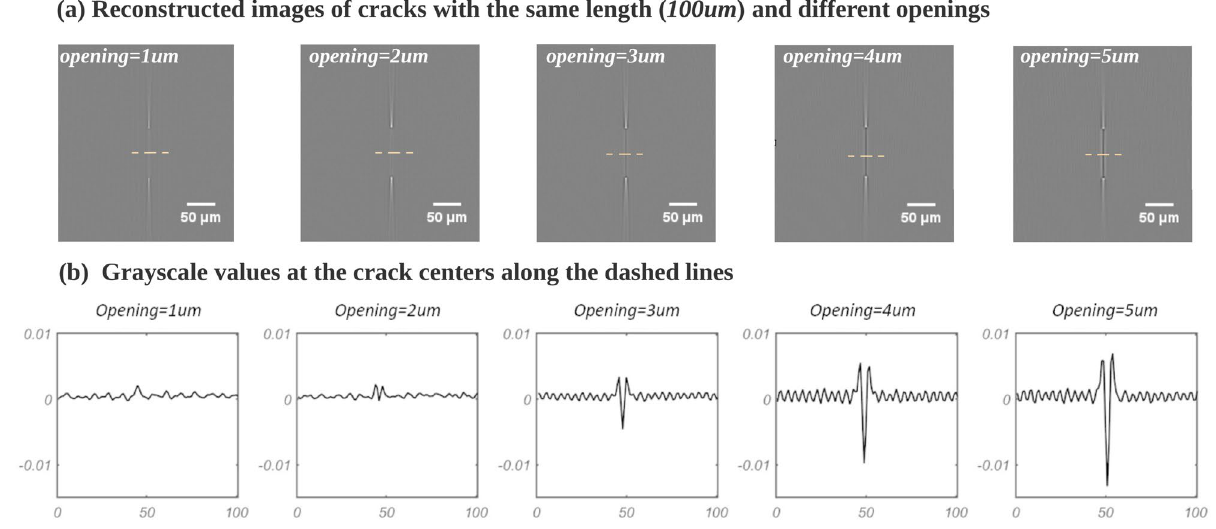
Figure 3. All slices are perpendicular to the axis of rotation: ( a ) Simulated images of cracks with openings ranging from 1 to 5 µ m; ( b ) Center profile of gray value of each crack: the contrast of the crack (as defined in Eq. 1) in the reconstructed image increases as the crack opening increases.